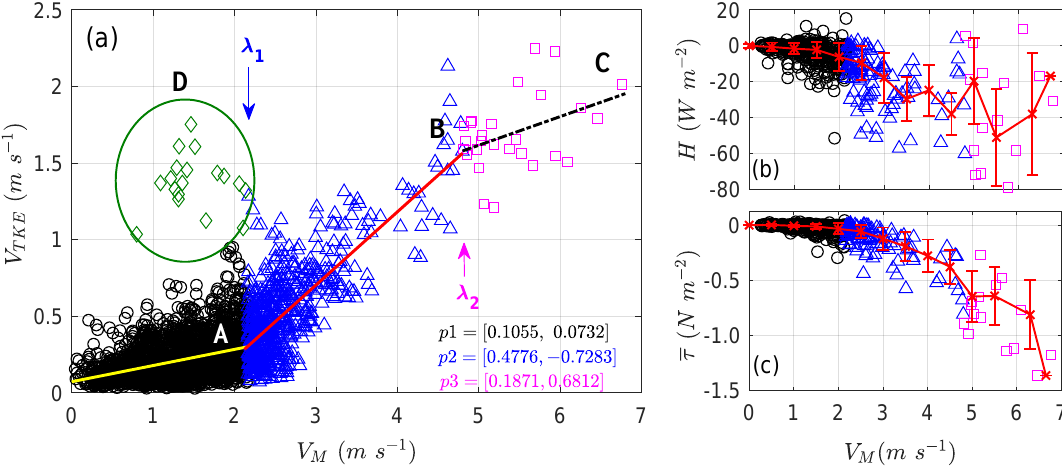
Figure 6. ( a ) Time evolution of the V TKE × V M relationship for the five nights analyzed: λ 1 indicates the transition threshold between the weak turbulence regime and the strong turbulence regime and λ 2 indicates the threshold between the strong and very strong turbulence regimes. The black circles represent occurrences of the weak turbulence regime in 0A segment; the green diamonds inside D ellipse represent occurrences of a top-down type of turbulent regime; the blue triangles in AB segment and the magenta squares near BC segment represent occurrences of two kinds of regime 2 features with strong turbulence regimes split into two sub-sets: the blue triangles, approximately bounded by of the line in red color (above λ 1 ), represent a type of strong turbulence regime that arises through a “natural” transition, not associated with the occurrence of an EP. The magenta squares mark the points of strong turbulence regime in which the value of V M was greater than λ 2 and correspond to situations in which the wind speed was maximum for the analyzed nights. p1, p2 and p3 are the slope and offset (i.e., angular and linear) coefficients of the lines 0A, AB and BC, respectively. ( b ) Sensible heat flux